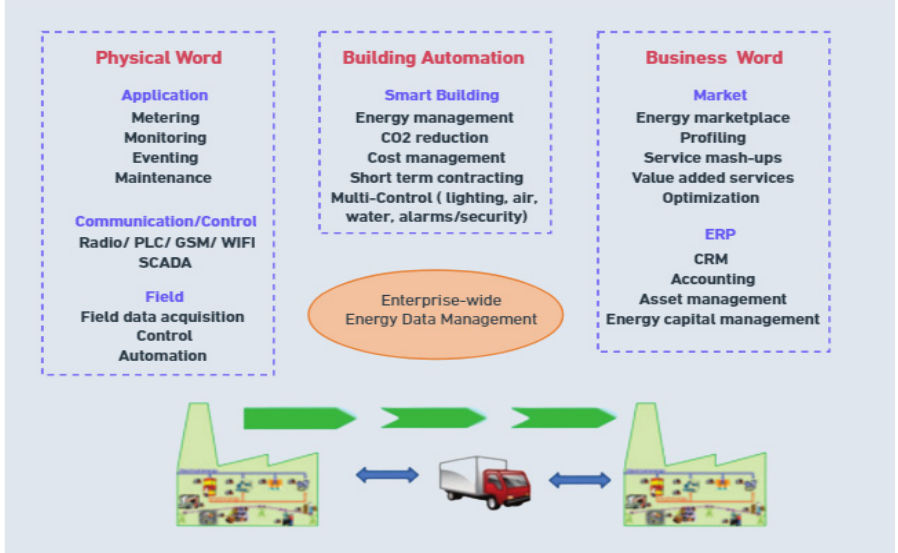
Figure 3. Cross-Enterprise Energy Efficiency for Factory of the Future.